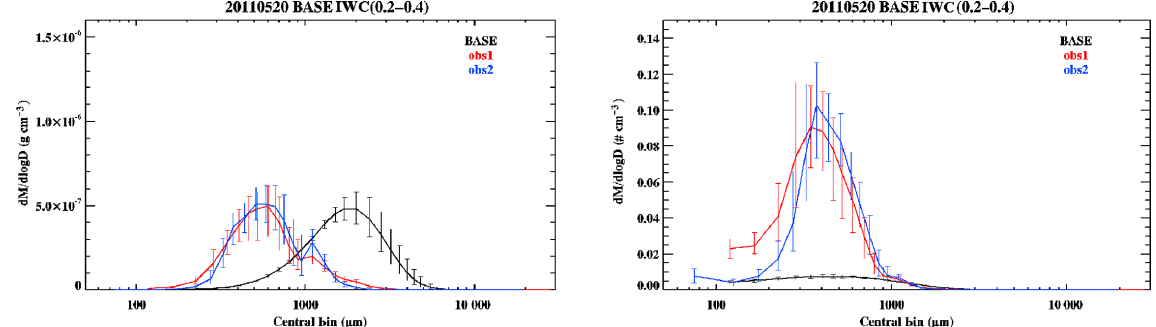
Figure 13. The same as Fig. 11 except at 7.6km ( − 23 ◦ C). No IWC greater than 0.4gm − 3 was measured at